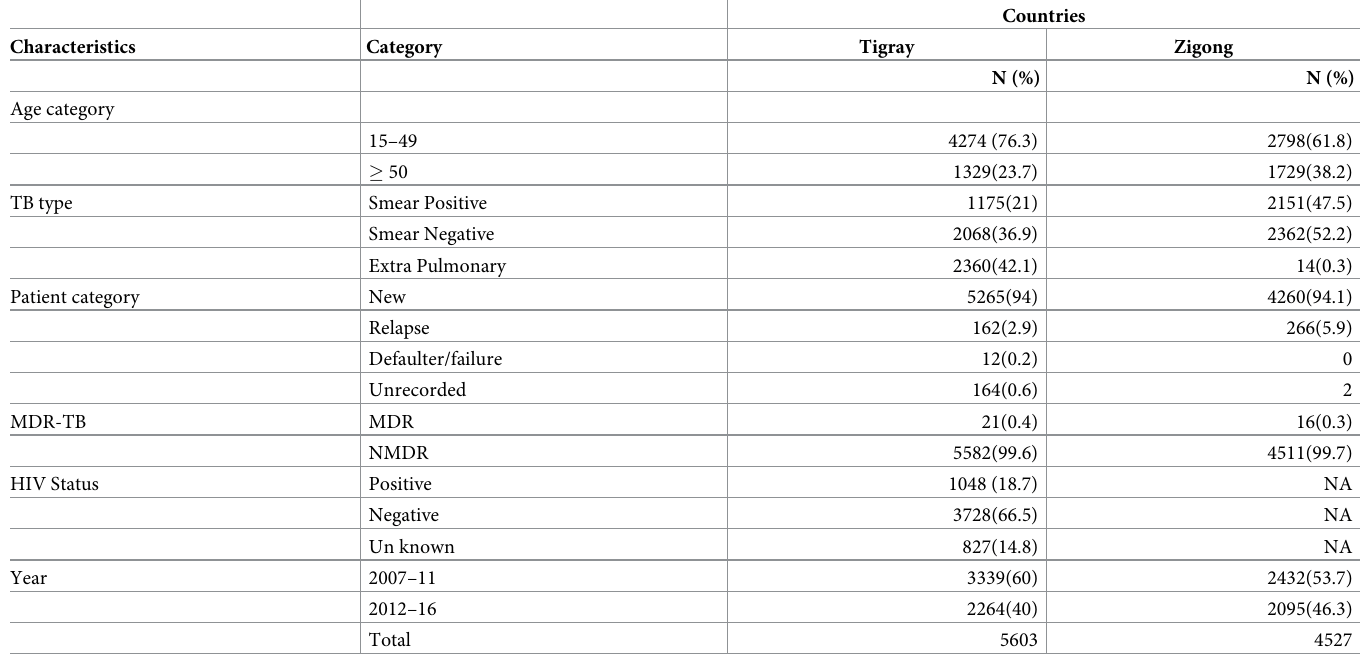
Table 1. General characteristic of women treated for tuberculosis in Tigray and Zigong January 2007–December 2016[N = 5603 and N =